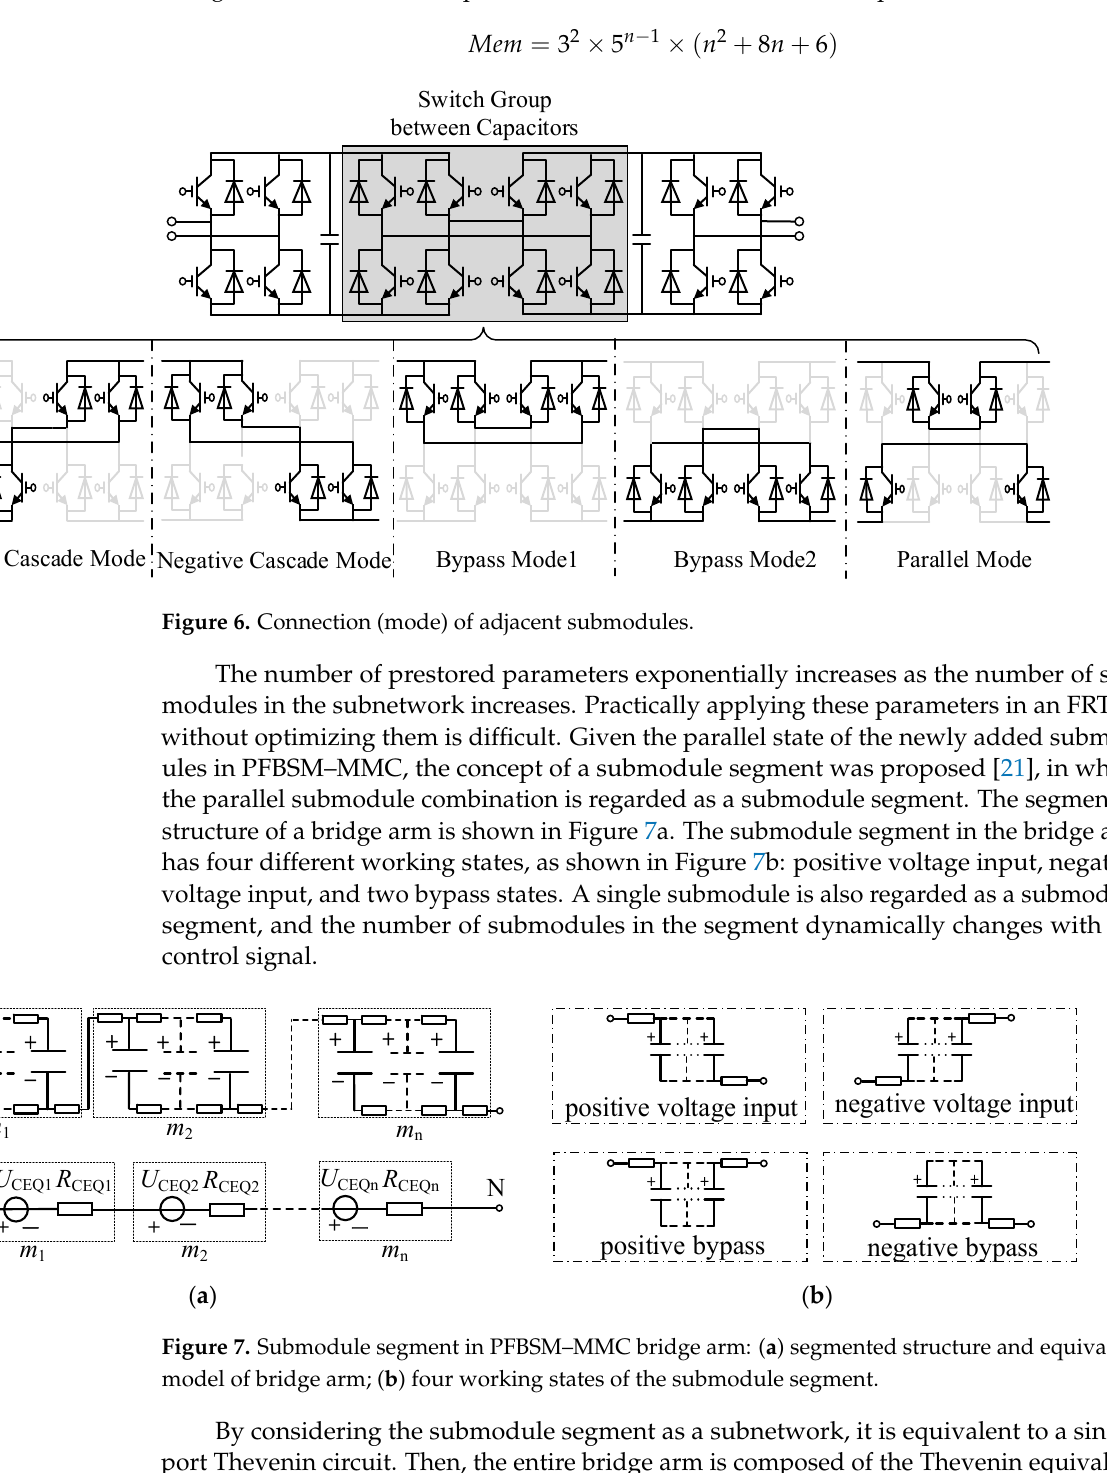
Figure 7. Submodule segment in PFBSM–MMC bridge arm: ( a ) segmented structure and equivalent